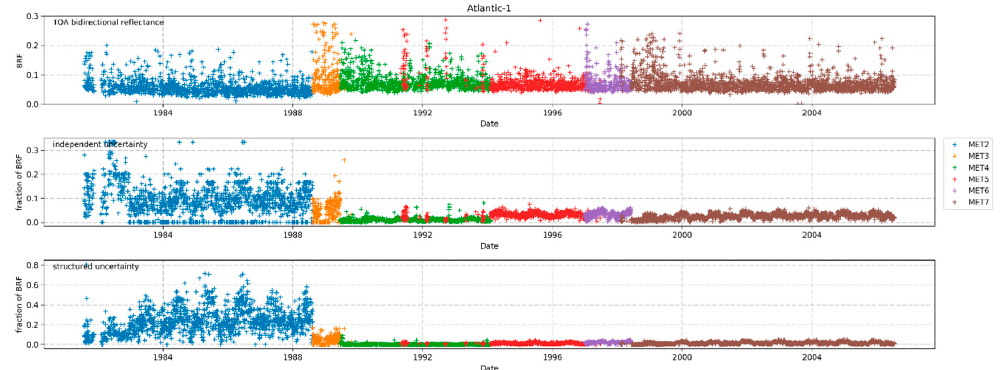
Figure 10. Harmonised MVIRI VIS FCDR time series of clear-sky reflectance at Atlantic-1 along with structured and independent uncertainties. Trends and jumps are due to the changing SRFs.